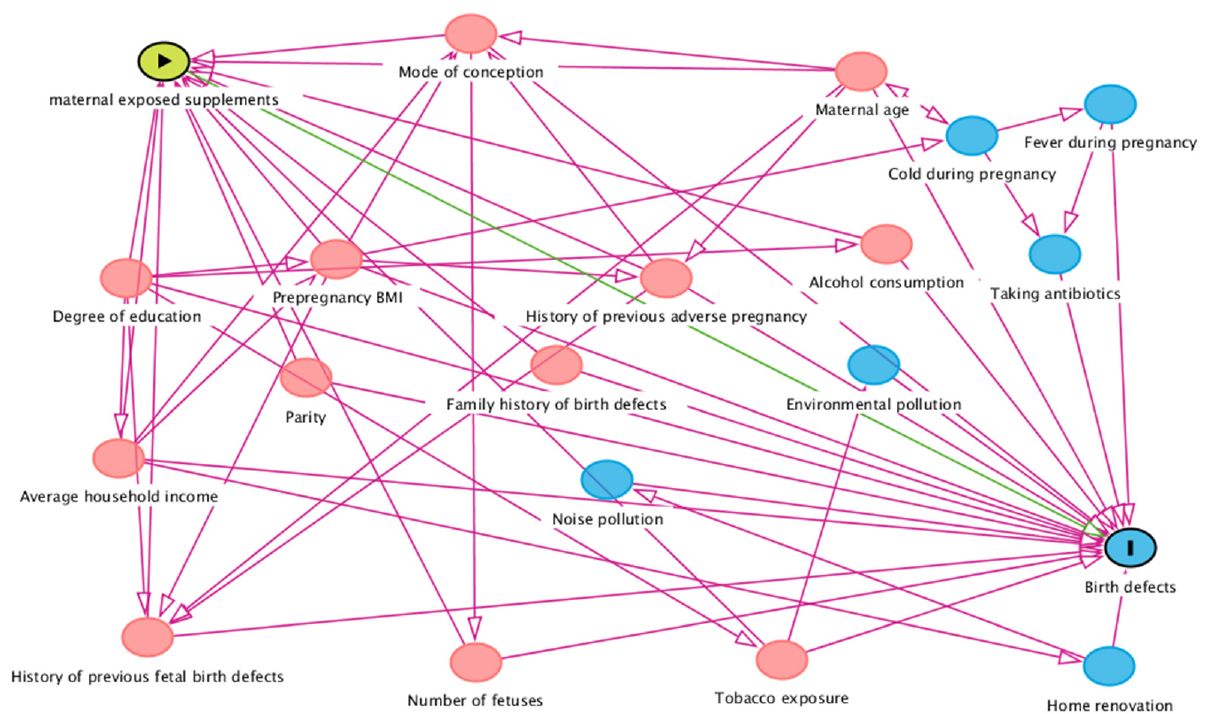
Figure 2. Directed acyclic graph based on supplements exposure and birth defects outcomes. Red circles represent variables included in the present statistical analysis and blue circles represent variables not included in the present statistical analysis. Right arrow in the yellow circle represent exposure factors, the vertical line in the blue circle represent outcome variable, the green line represent direct causal path.